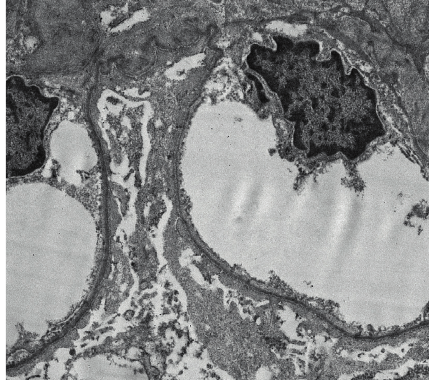
Figure 2: Renal electron microscopy showing diffuse effacement of visceral epithelial cell foot processes and mesangial electron-dense